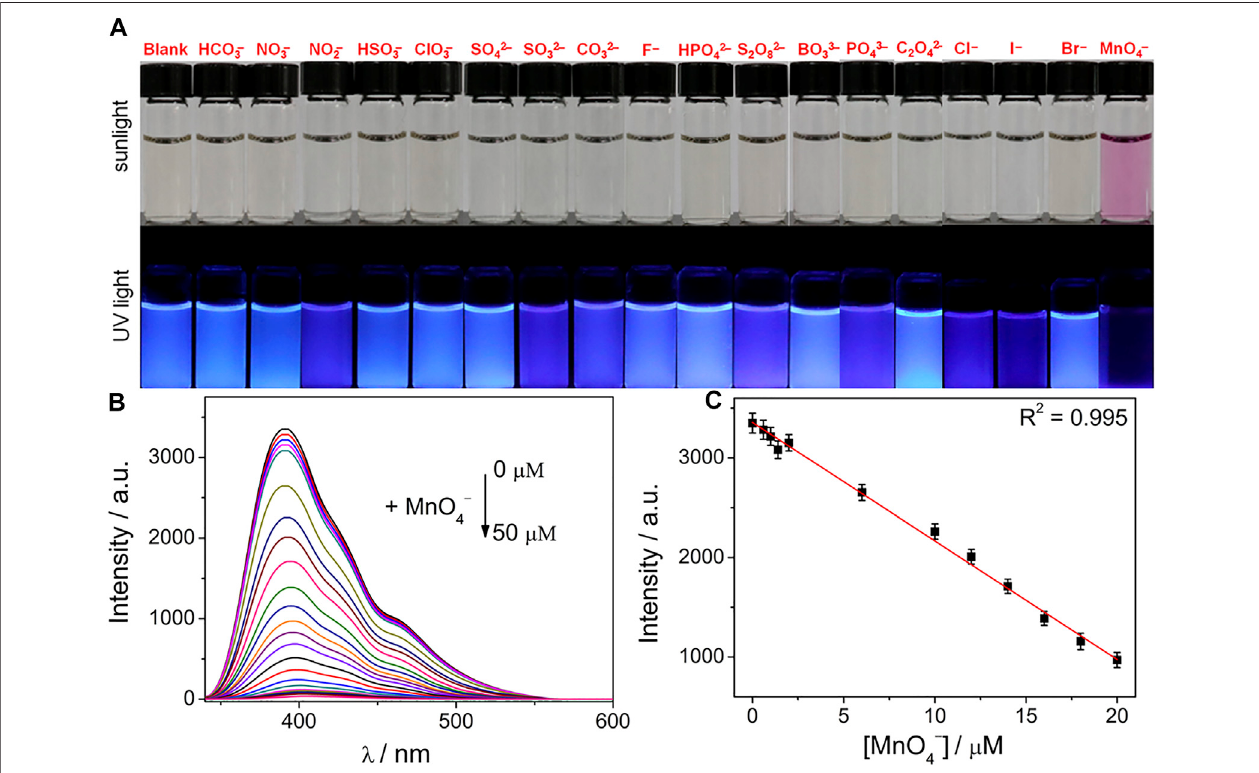
FIGURE5|(A) PhotographsofN/PCD solutioninthe presence ofvarious anions(50 μ M) under sunlight and UVlight(365 nm). (B) Fluorescence responseofN/P CDs (10 μ g · mL − 1 ) upon addition of various concentrations of MnO 4 − (0 – 50 μ M) in HEPES buffer (10 mM, pH 7.4). (C) Linear relationship of the fl uorescence intensity against MnO 4 − concentrations.